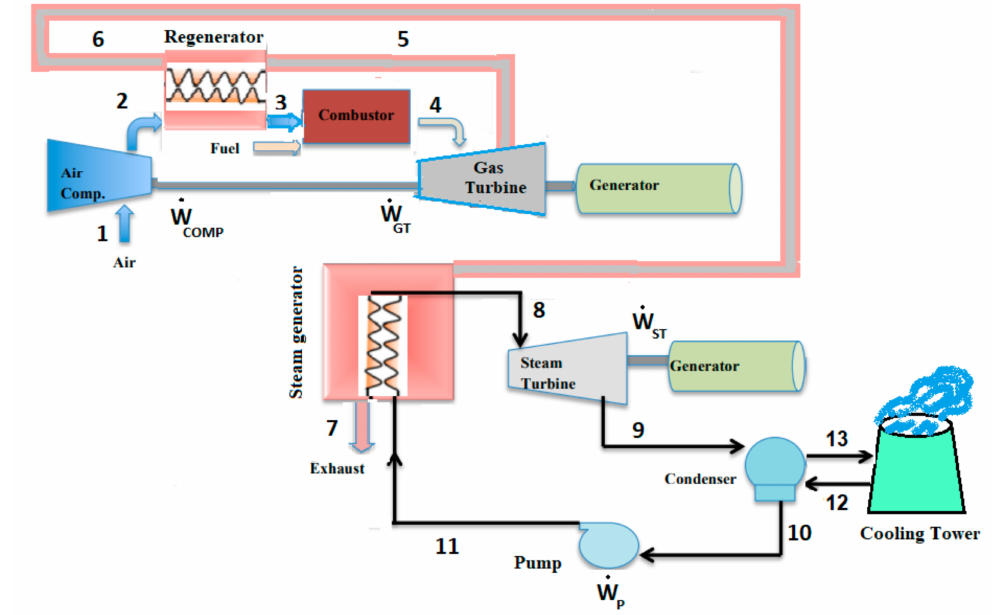
Figure 2. Schematic of the combined regenerative Brayton and Rankine cycle (Config. 2).